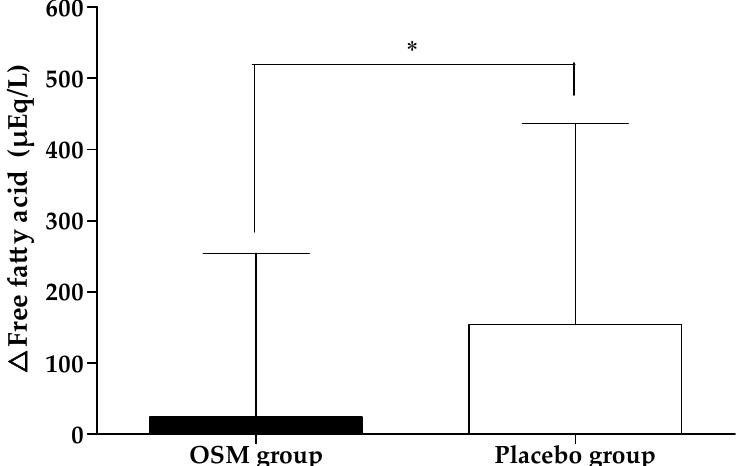
Figure 3. Effects of OSM on changes in plasma LDL-cholesterol and free fatty acid levels from baseline after taking the supplement for 12 weeks. Subjects in OSM groups were administered OSM at 500 mg/day for 12 weeks. Data are expressed as means ± SD. Between-group differences were assessed using ANCOVA (adjusted on the baseline of FPG, HbA1c). * p < 0.05 vs. placebo group.